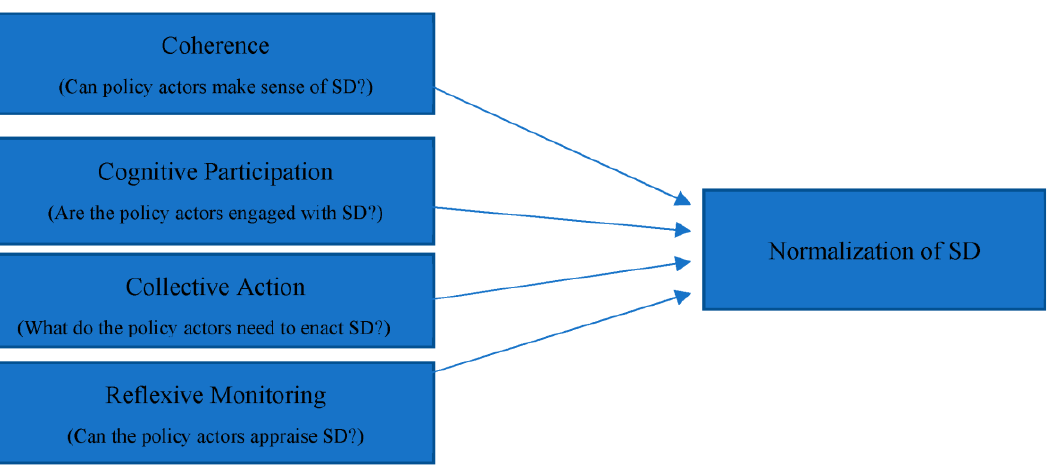
Figure 2. Theoretical framework.